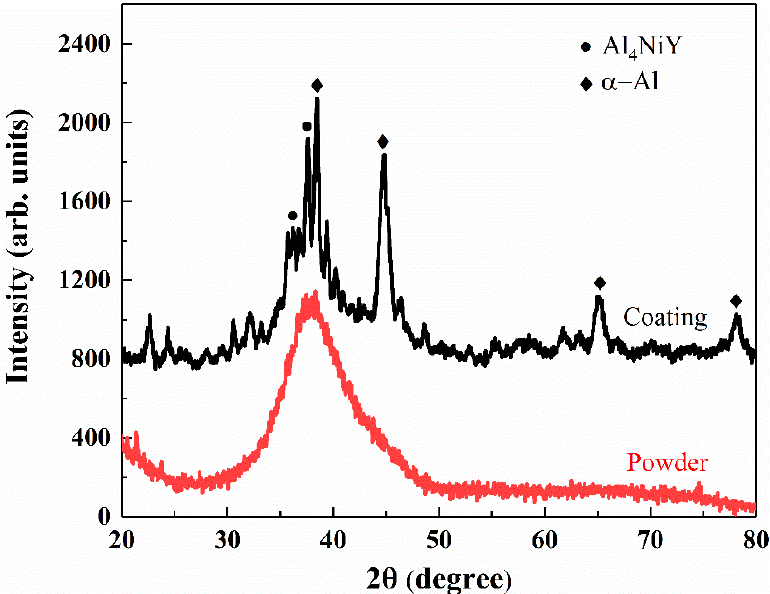
Figure 2. X-ray diffraction (XRD) patterns for the atomized powders and the HVAF-sprayed coating.